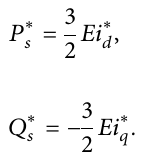
Figure 9: MMC-BESS main control